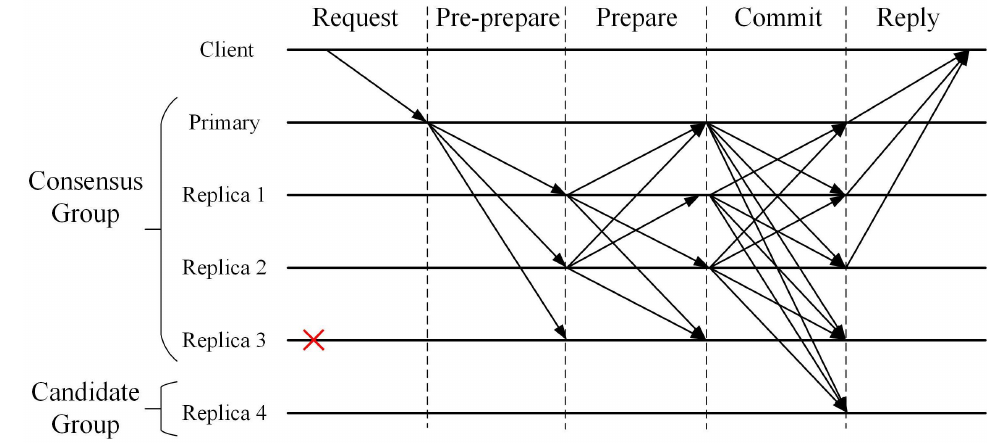
Figure 4. The optimized consensus